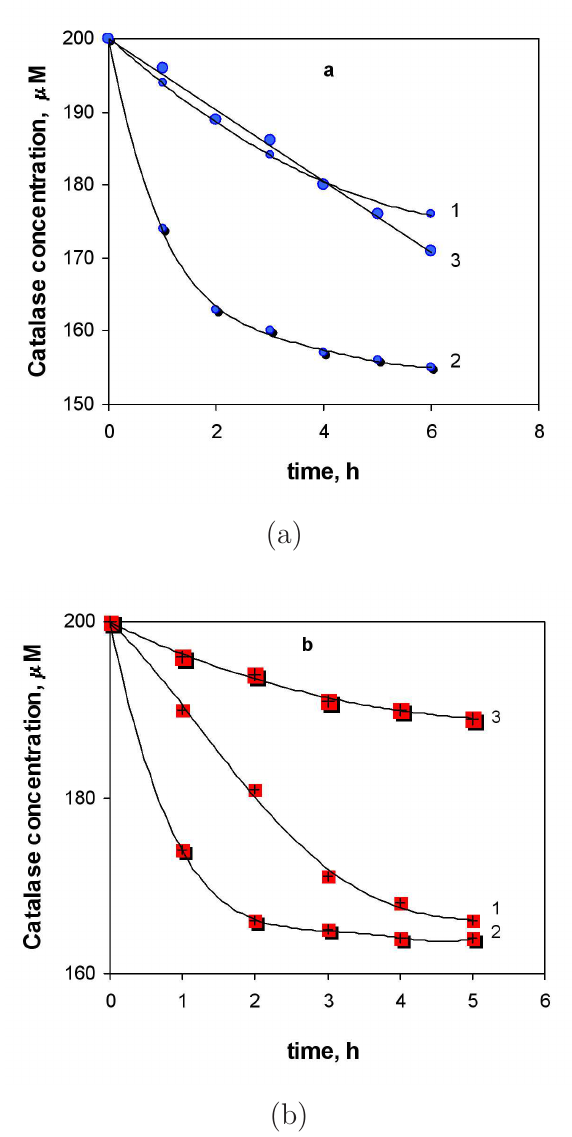
Fig. 3 Kinetic curves of catalase adsorption on activated carbon NORIT (a) and on carbon black PM-100 (b) at temperatures: 1) 4 ◦ C; 2) 24 ± 1 o C; 3) 32 ◦ C. Start concentration of the enzyme solution 200 µ M; pH =